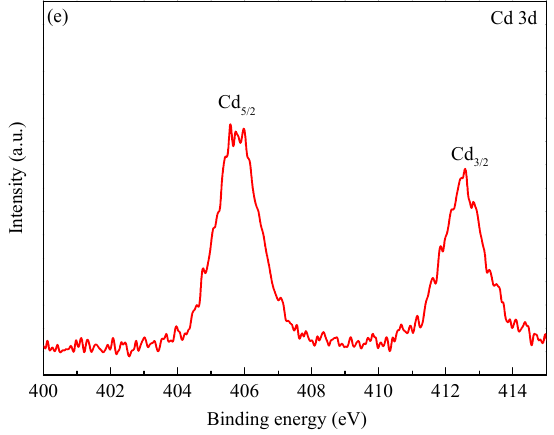
Figure 10. Wide-scan XPS survey of nZVI/rGO and nZVI/rGO-Cd(II) ( a ); high-resolution spectra of C 1s for nZVI/rGO and nZVI/rGO-Cd(II) ( b ); high-resolution spectra of O 1s for nZVI/rGO and nZVI/rGO-Cd(II) ( c ); high-resolution spectra of Fe 2p for nZVI/rGO and nZVI/rGO-Cd(II) ( d ); high-resolution spectrum of Cd 3d for nZVI/rGO-Cd(II) ( e ). (Initial Cd(II) concentration = 100 mg/L; initial pH = 7; nZVI/rGO composites = 300 mg; contact time = 1 h; operating temperature = 20 °C).